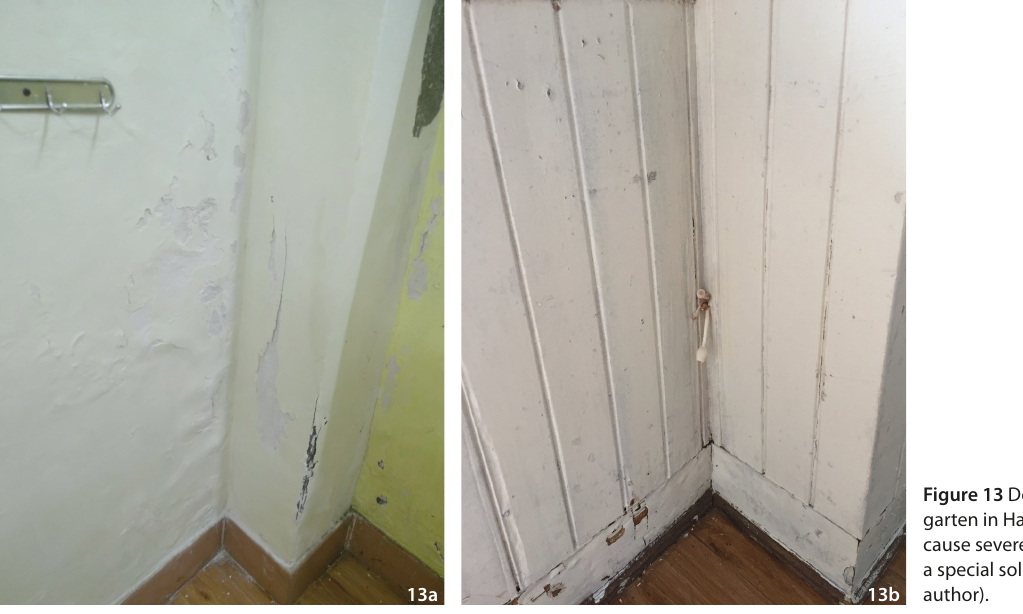
Figure 13 Defects in one kinder- garten in Hangzhou, which may cause severe health risks, need a special solution (Source: the author). 13a